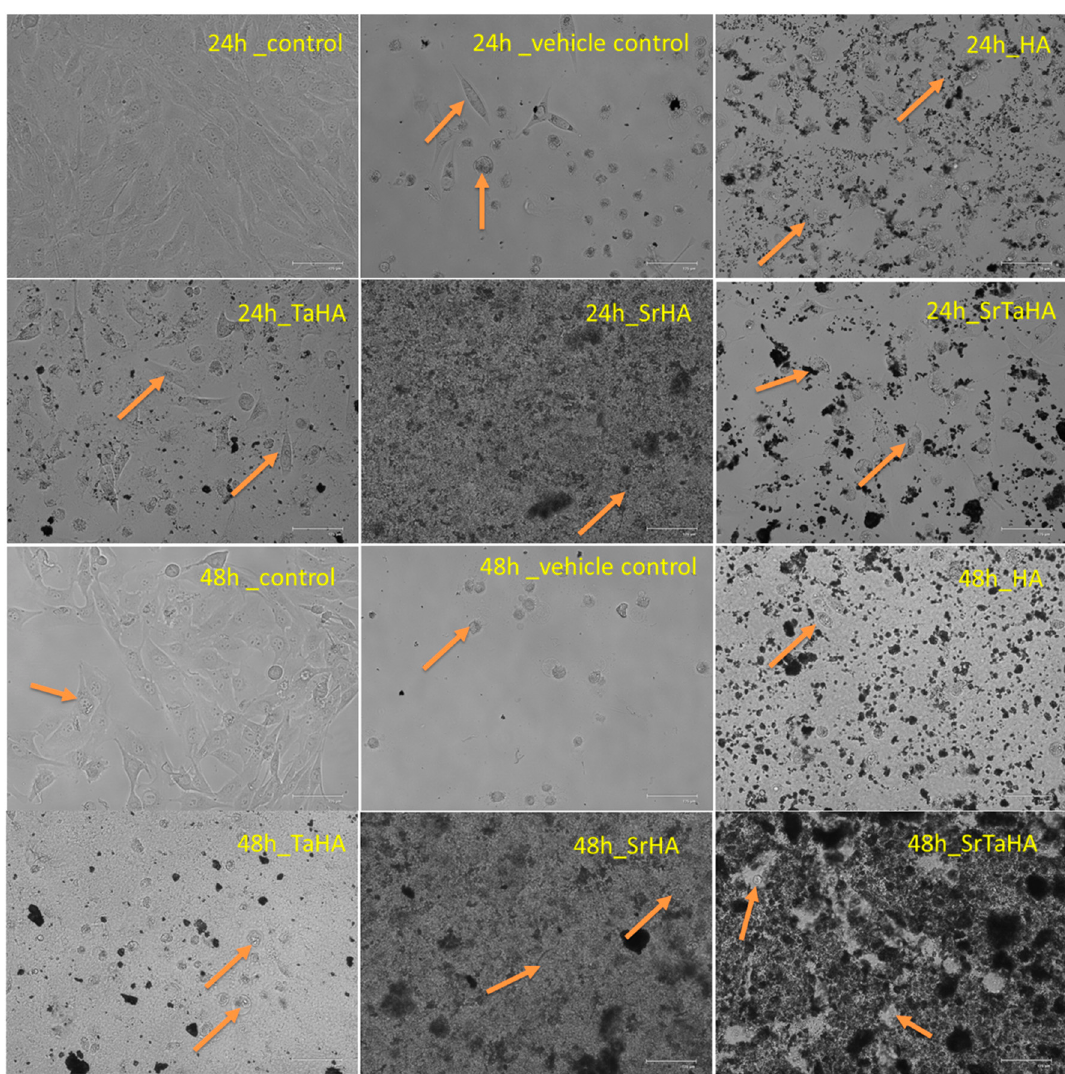
Figure 14. Optical density (OD) of the samples after 24 h and 48 h MTT assay.